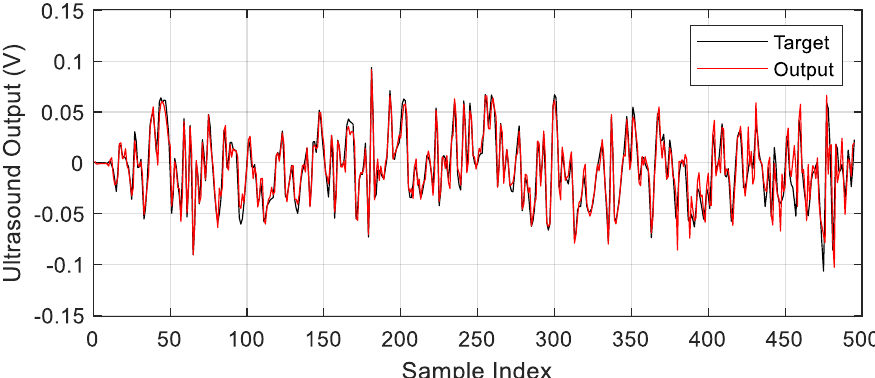
Figure 5. Comparison between predicted and real data assuming an FCM structure for the testing phase.